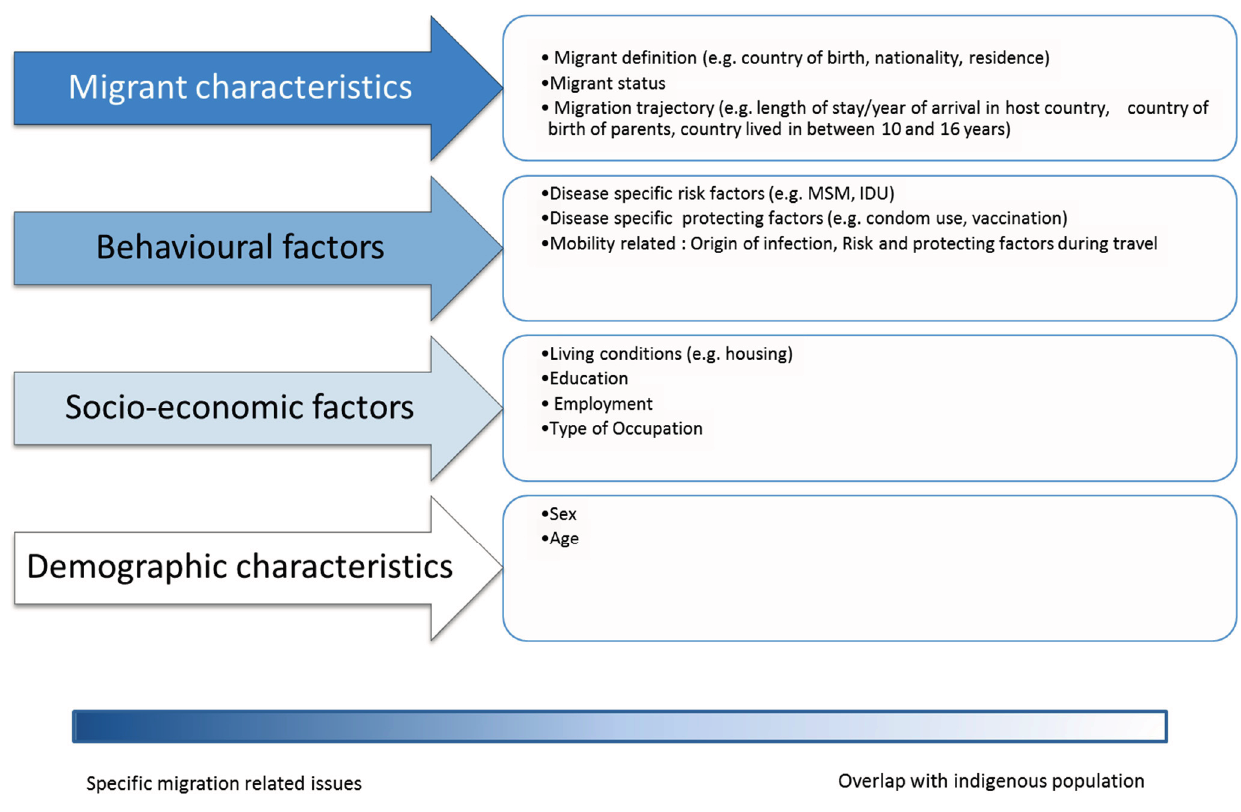
Figure 1. Factors/characteristics identifying the four data collection domains and examples of type of variables under each